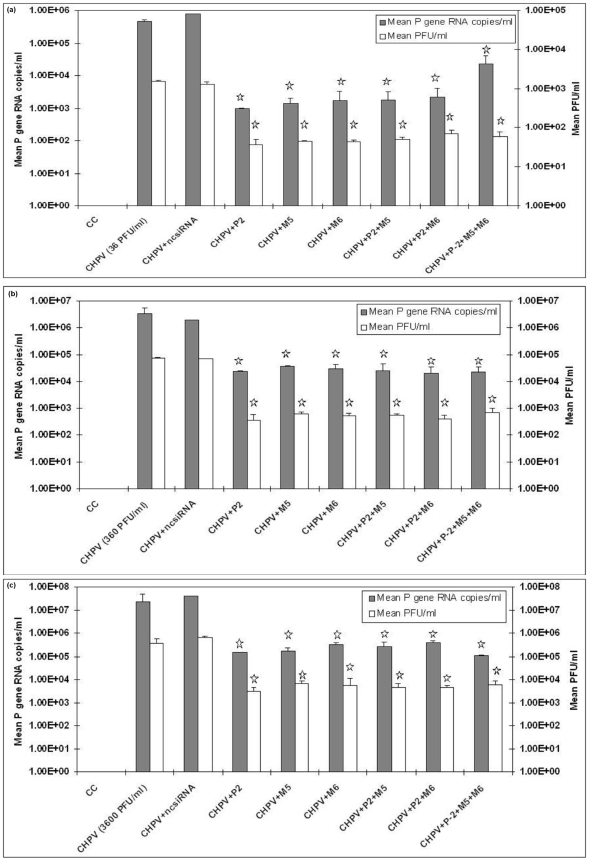
Effect of P-2, M-5 and M-6 siRNAs on the replication of CHPV.(a) The virus inoculum was 36 PFU/ml, (b) 360 PFU/ml and (c) 3600 PFU/ml. Results are expressed as means ± SD. * indicates significantly different from control at p<0.05 by Dunnett's test.